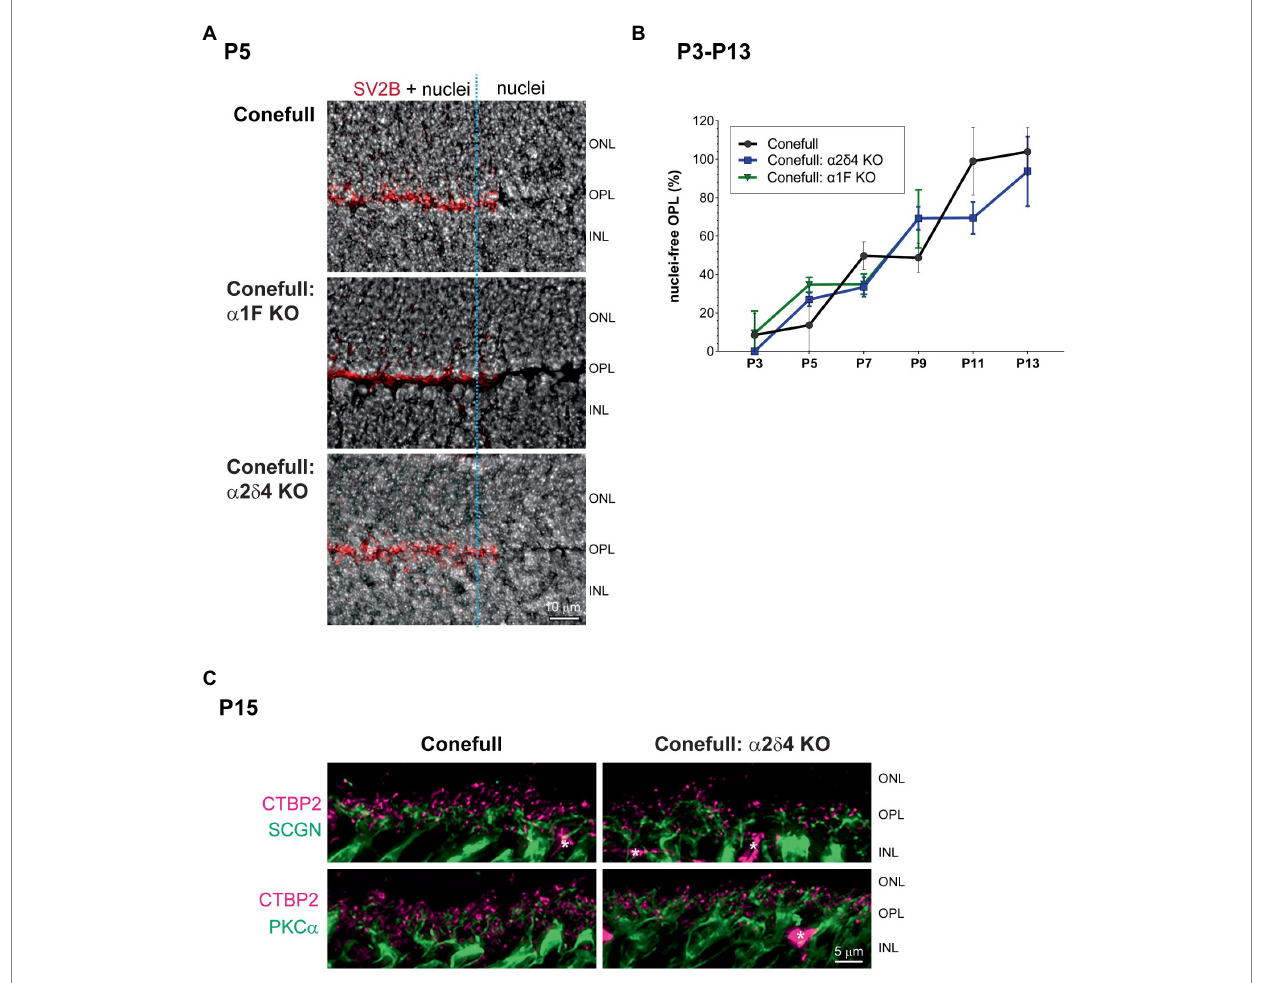
FIGURE 6 Development of the OPL is similar in Conefull and Conefull: Cav1.4 mutants. (A) Representative Hoechst stained P5 retinas of each genotype labeled with SV2B (red) to mark the presynaptic terminal in the developing OPL. The right 1/3 of each image (marked with the blue dashed line) has the SV2B channel removed to clearly show the nuclei-free OPL. Scale bar is 10 μ m. (B) The area (mean ± S.D.) of the nuclear-free zone between the developing ONL and INL was measured from images as shown in Figure 5 and A then plotted as a function of animal age from P3-P13 for Conefull and Conefull: α 2 δ 4 KO (blue line). Conefull: α 1F KO (green line) could only be measured from P3-P9 because retina morphology was disrupted by neural rosettes at the later timepoints. (C) Comparison of synapses in the OPL at P15 in Conefull compared to Conefull: α 2 δ 4 KO retina. Presynaptic ribbons labeled with CTBP2 (magenta) and bipolar cell dendrites (green) with secretagogin (SCGN) for a subset of cone ON and OFF bipolar cells in the upper panels or PKC α for rod ON bipolar cells in the lower panels. Asterisks indicate non-specific labeling of blood vessels by the secondary antibody, scale bar is 5 μ